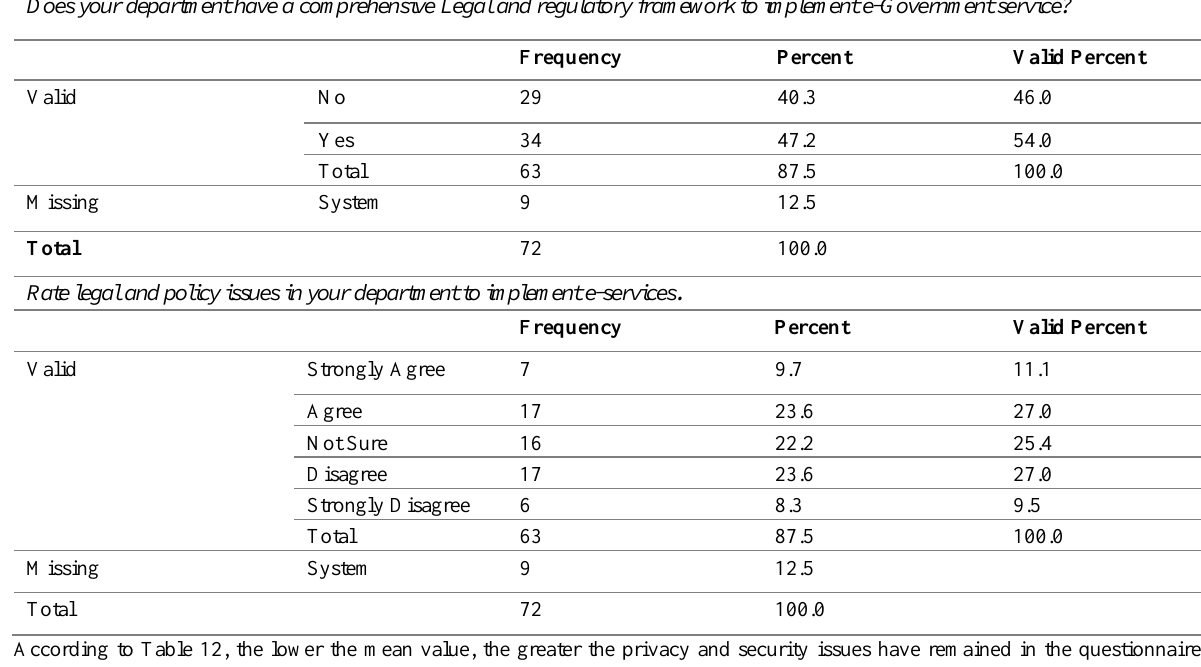
Table 11: Legal and Regulatory Barrier